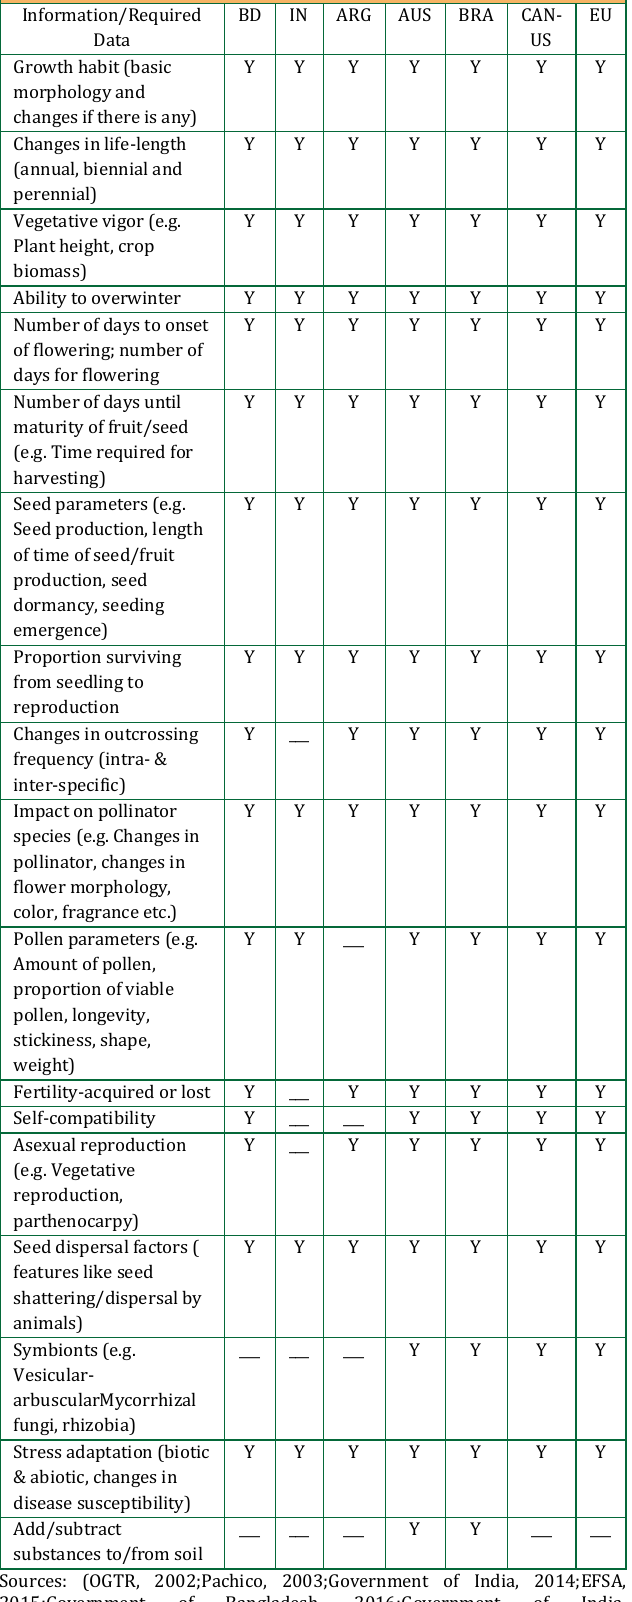
Table 4: Comparative analysis of data requirement on the phenotypic characteristics of the GE plants